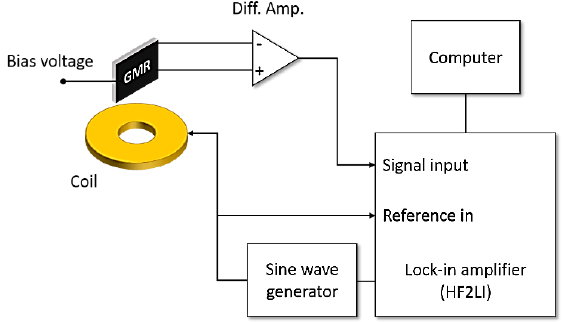
FIGURE 6. Schematization of the measurement system.